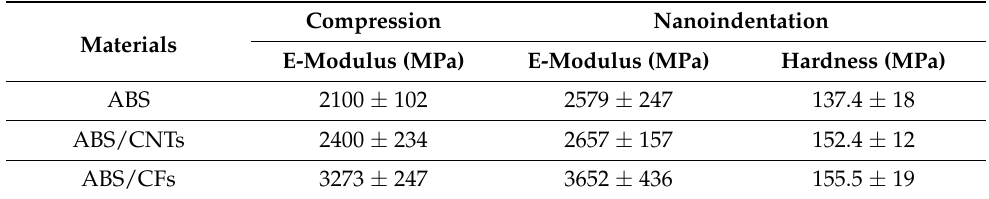
Table 1. Compressive and nanoindentation properties of the ABS, ABS/CNT and ABS/CF specimens.